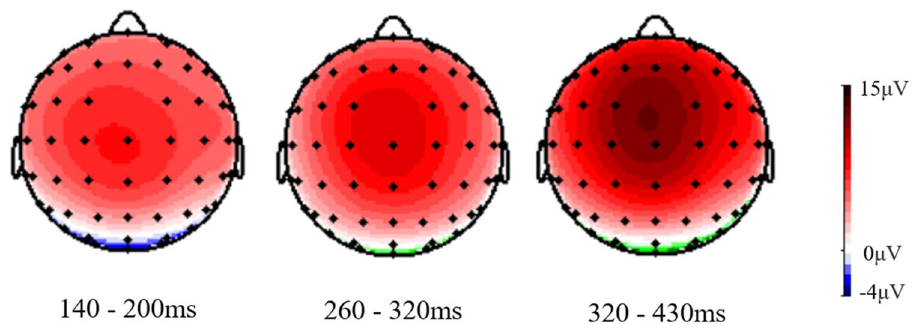
Figure 4. Topographical maps of the averaged ERP